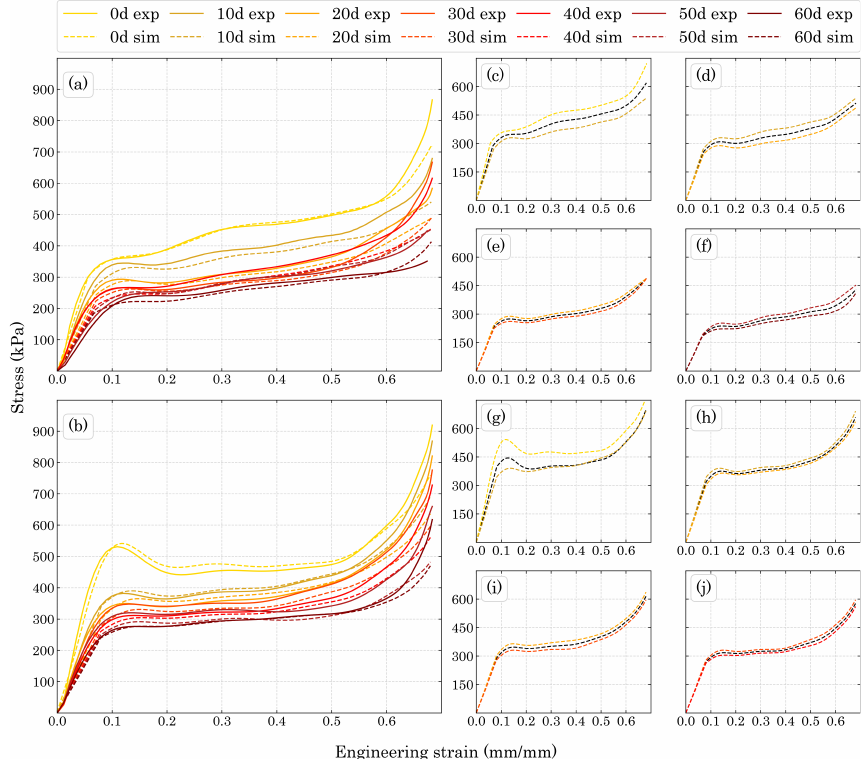
Figure 13. Numerical and experimental results with their respective degradation time for ( a ) Dir3 and ( b ) Dir1. Simulation for Dir3 with ageing period of ( c ) 5, ( d ) 15, ( e ) 25, and ( f ) 55 days and simulation for Dir1 for aging periods of ( g ) 5, ( h ) 15, ( i ) 25, and ( j ) 35